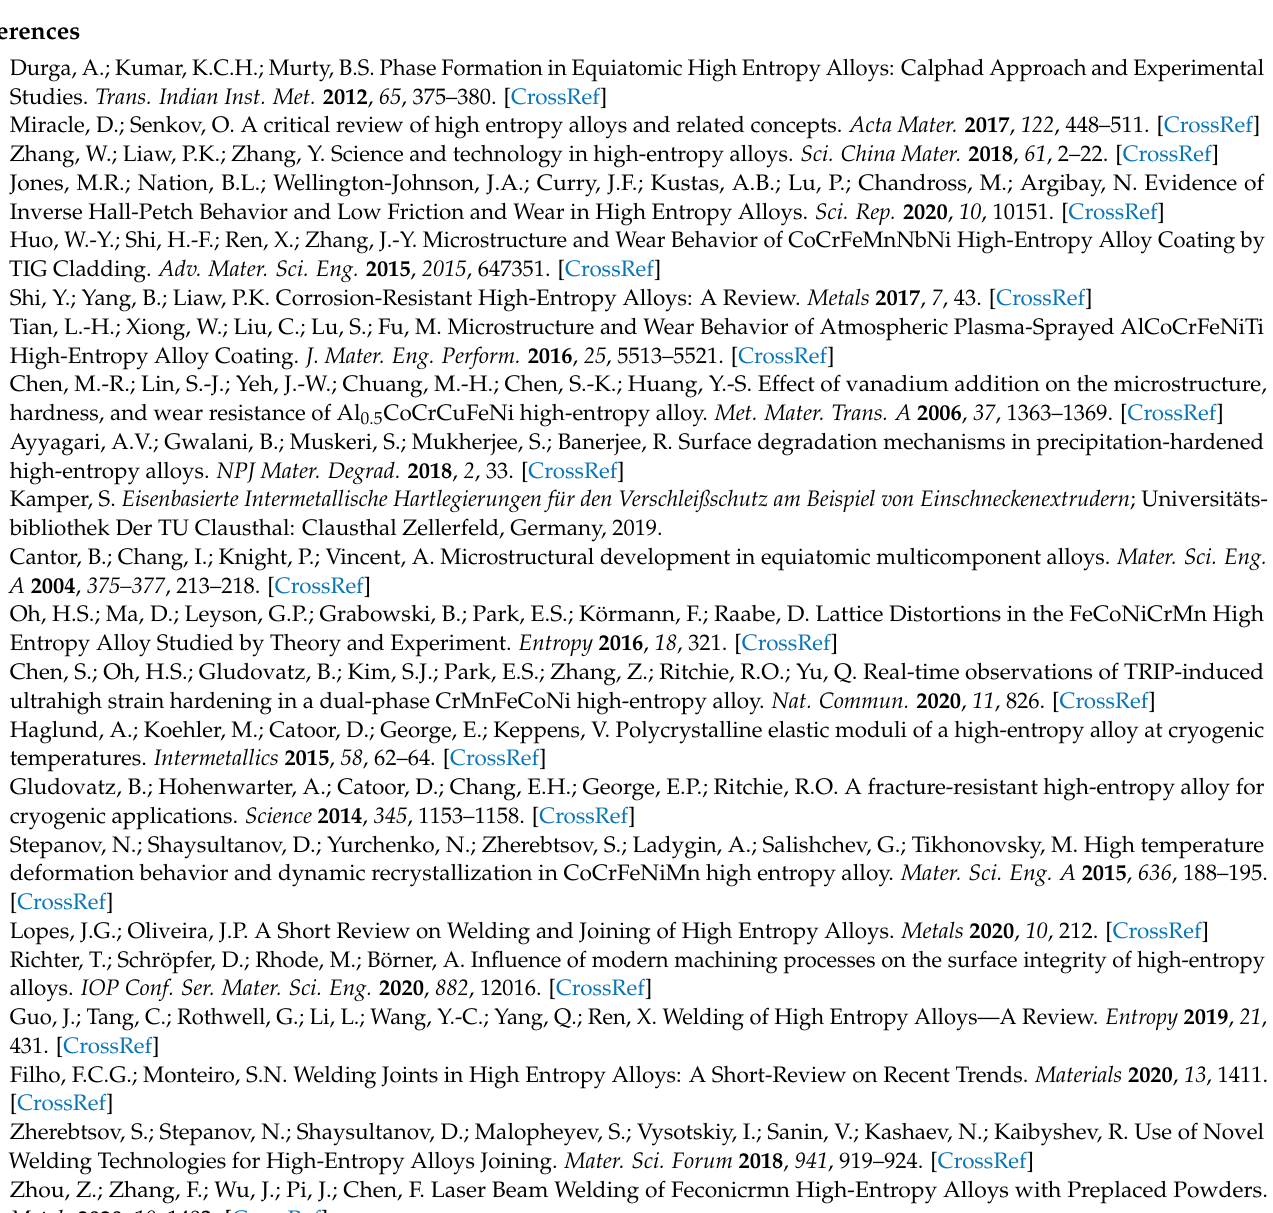
Figure A4. EDX-Spectrum for EDX Point